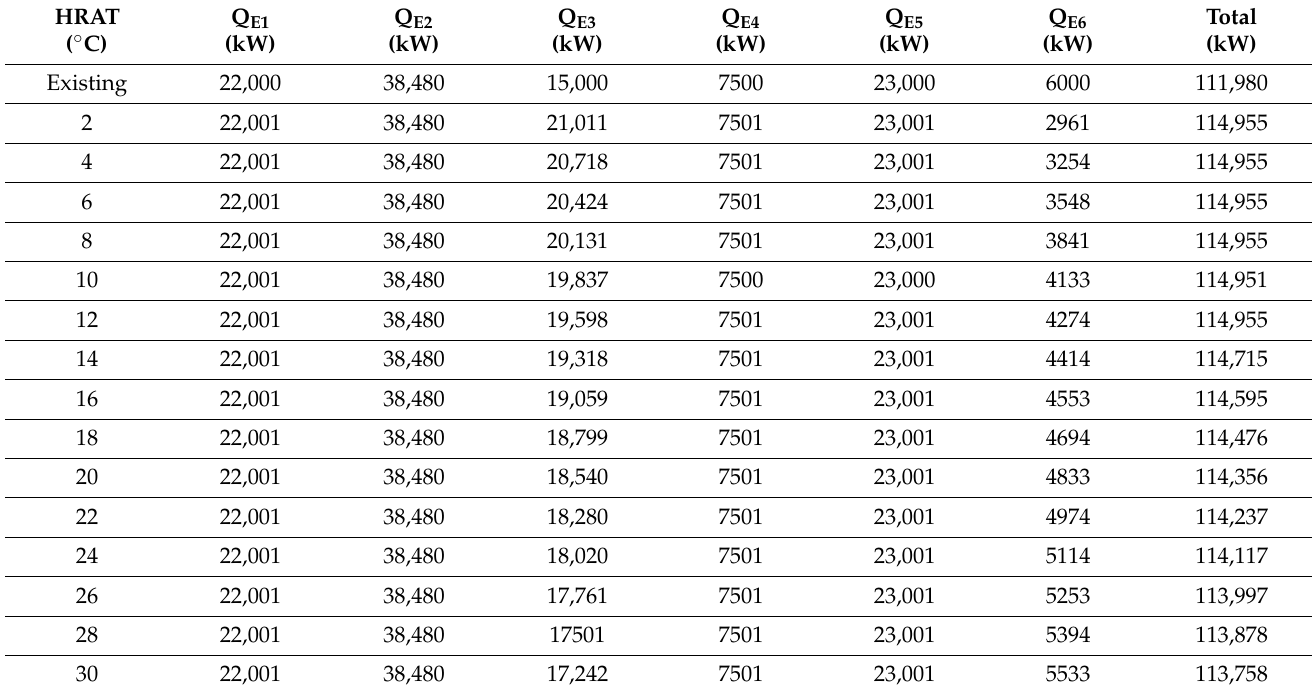
Table A5. Heat loads at different HRAT values for option